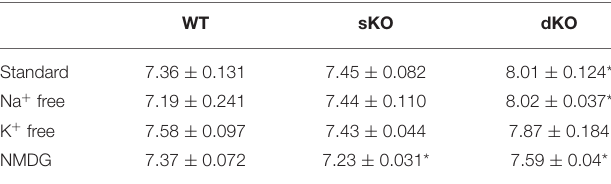
TABLE 2 | Intracellular pH of